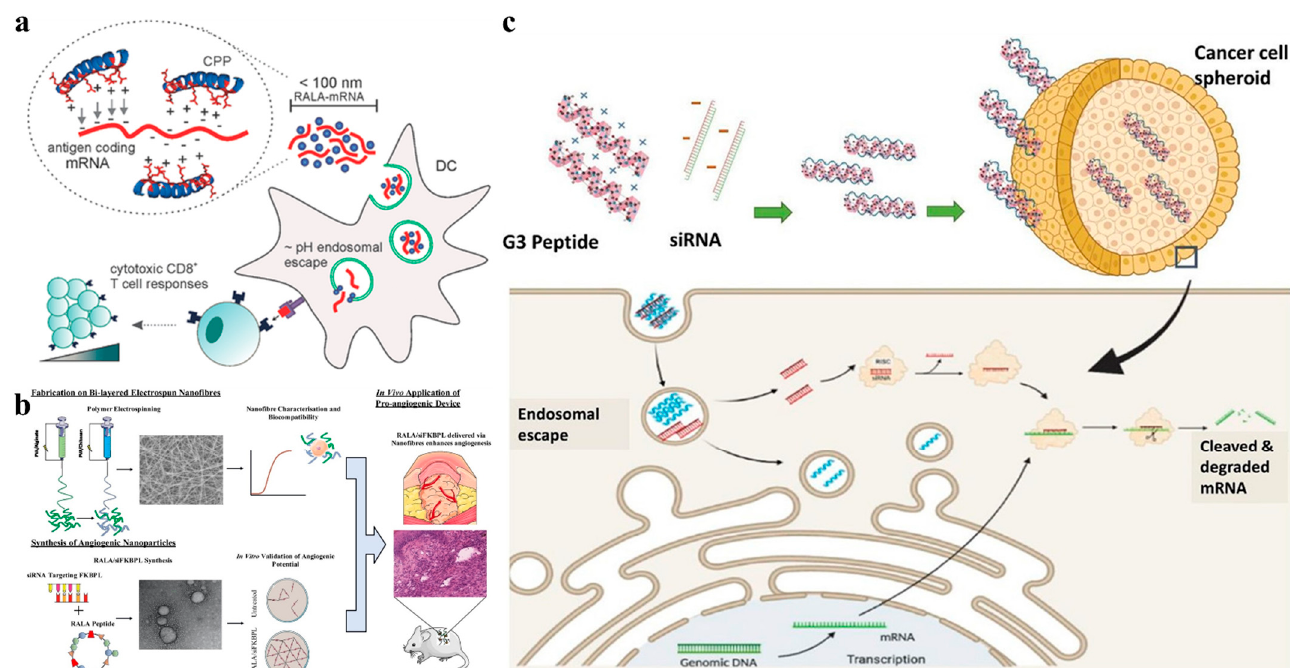
Figure 5. ( a ) RALA peptides condense mRNA into nanoparticles, releasing mRNA in dendritic cell cytosol to promote antigen specific T cell proliferation. Reprinted with permission from Ref. [43]. Copyright 2017, Wiley Online Library. ( b ) RALA peptides form a complex with siRNA to deliver siRNA into the cell and promote the regeneration of blood vessels. Reprinted with permission from Ref. [44]. Copyright 2019, Elsevier. ( c ) G3 peptide was assembled with siRNA and delivered to cancer cells, where siRNA was released to regulate gene expression in cancer cells. Reprinted with permission from Ref. [50]. Copyright 2021, American Chemical Society.